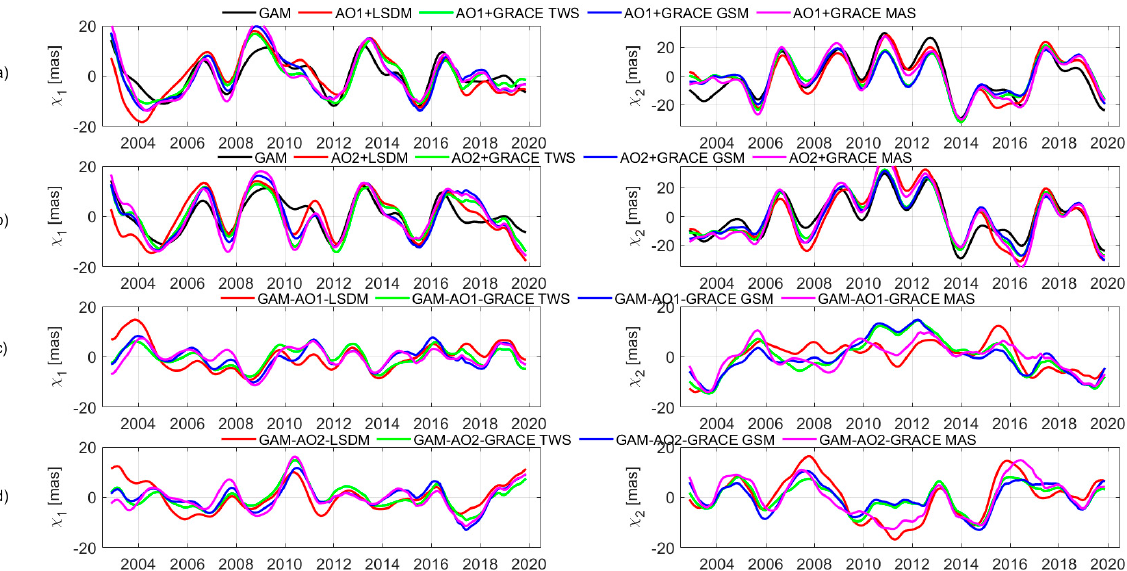
Figure 5. Comparison between observed geodetic excitation functions and ( a ) monthly geophysical excitations for AO1 improved by HAM LSDM hydrological model, GRACE GSM, GRACE TWS, and GRACE MAS gravimetric excitations; ( b ) monthly geophysical excitations for AO2 improved by HAM LSDM hydrological model, GRACE GSM, GRACE TWS, and GRACE MAS gravimetric excitations; ( c ) differences between GAM and the sum of AO1 + HAM; and ( d ) differences between GAM and the sum of AO2 + HAM, for χ 1 and χ 2 equatorial